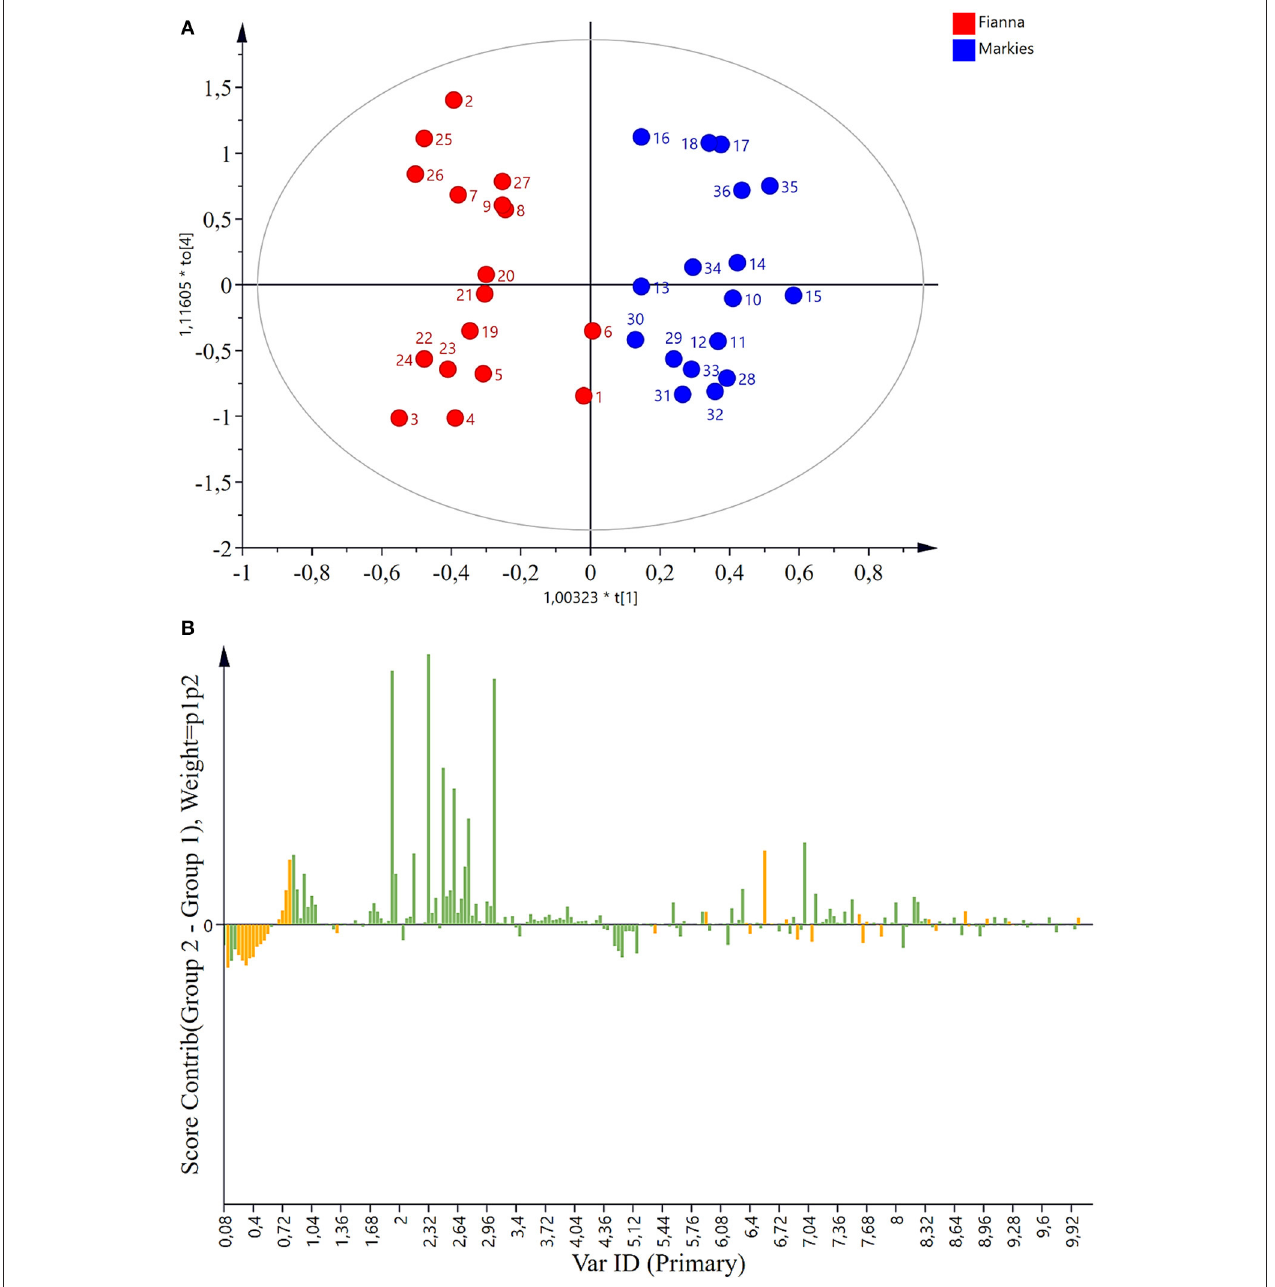
FIGURE 1 | (A) OPLSA-DA statistical plot showing the separation between Markies and Fianna potato cultivars. (B) Loadings of each variable in the contribution plot of OPLS-DA illustrating chemical shifts from the Fianna and Markies potato cultivars that received the control, flooding or drought irrigation treatments.